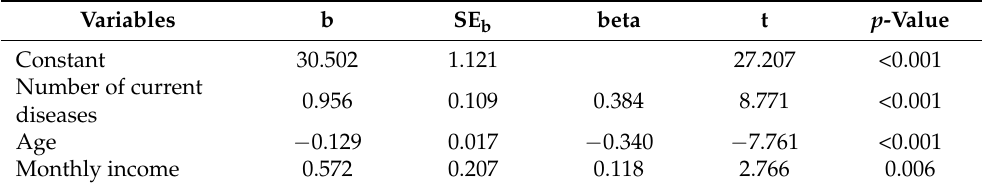
Table 5. Factors associated with WAI among the working population in stepwise multiple regression